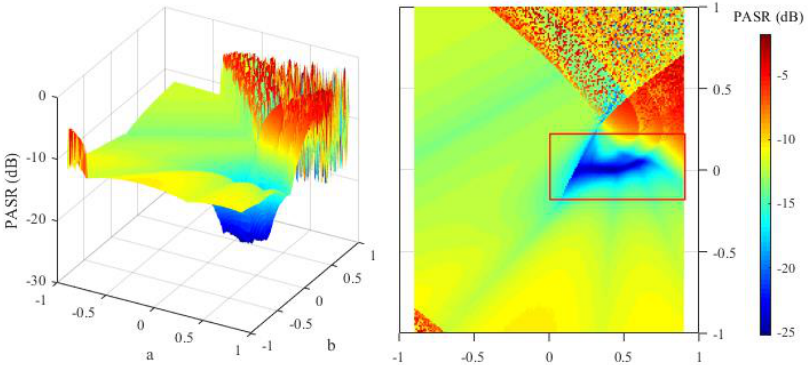
Figure 4. PASR values of different NLFM parameters under group 1 of sub-chirp rate PM code matrix and sub-chirp sequence code matrix.